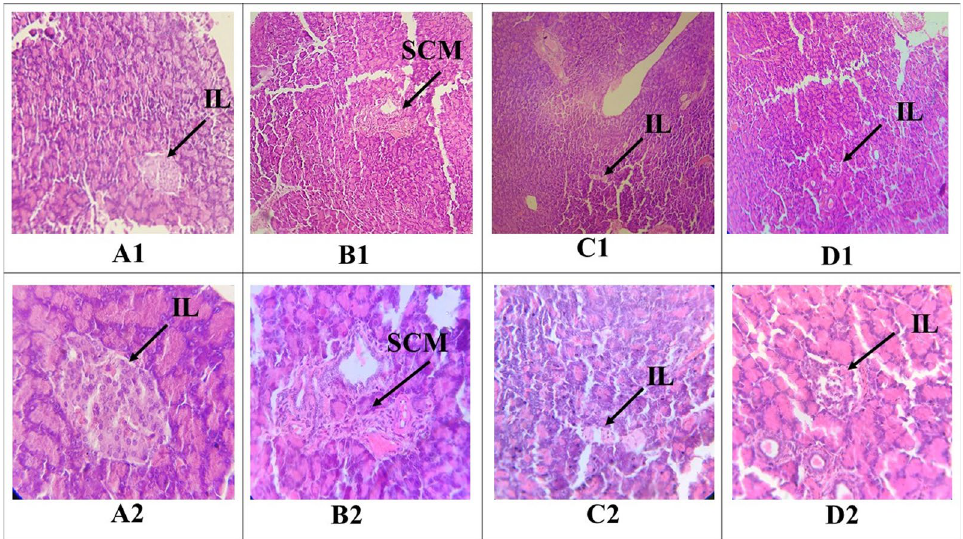
Fig. 5 Histopathological changes of the Pancreas of the control and various experimental groups of rats. IL indicates the Pancreatic Islets of Langerhans and SCM indicates the shrinking cell mass (A1 and A2—Tc group at 100 400 magnification, C1 and C2—Tae group at 100 ×